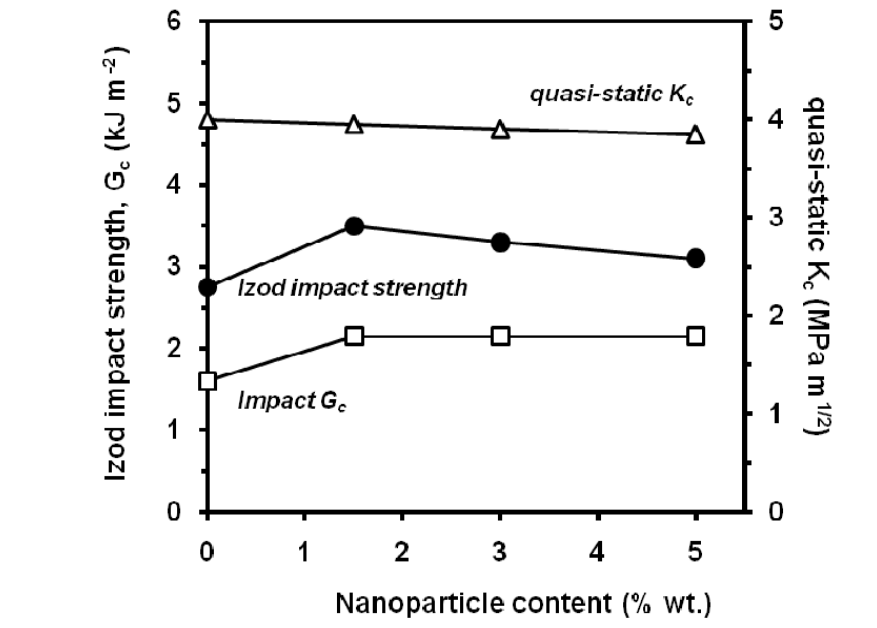
Figure 38. Effect of aluminium oxide nanoparticles on quasi-static and dynamic fracture parameters(adapted from [141]).